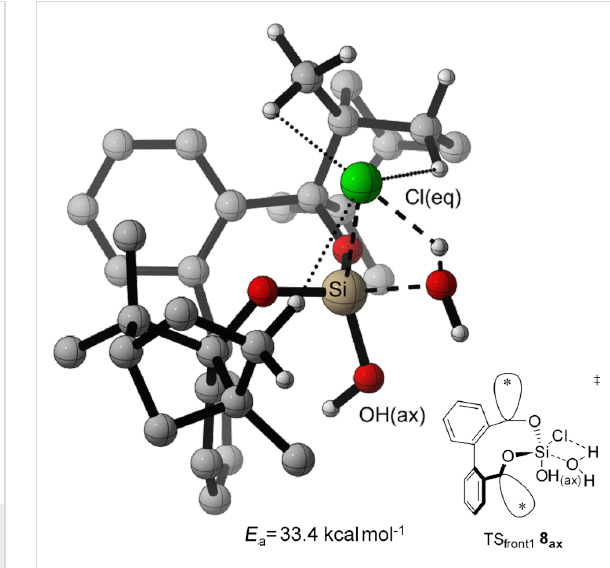
Figure 10: Transition state leading to 9 following front1 attack ( E a = 33.4 kcal mol − 1 , Figure 5, Table 3, entry 4). Breaking and forming bonds in dashed lines, additional C–H-interactions with dotted lines (M06-2X-D3/6-311++G(d,p)(PCM=THF)//B3LYP-D3BJ/6-31G(d) at 298 K).